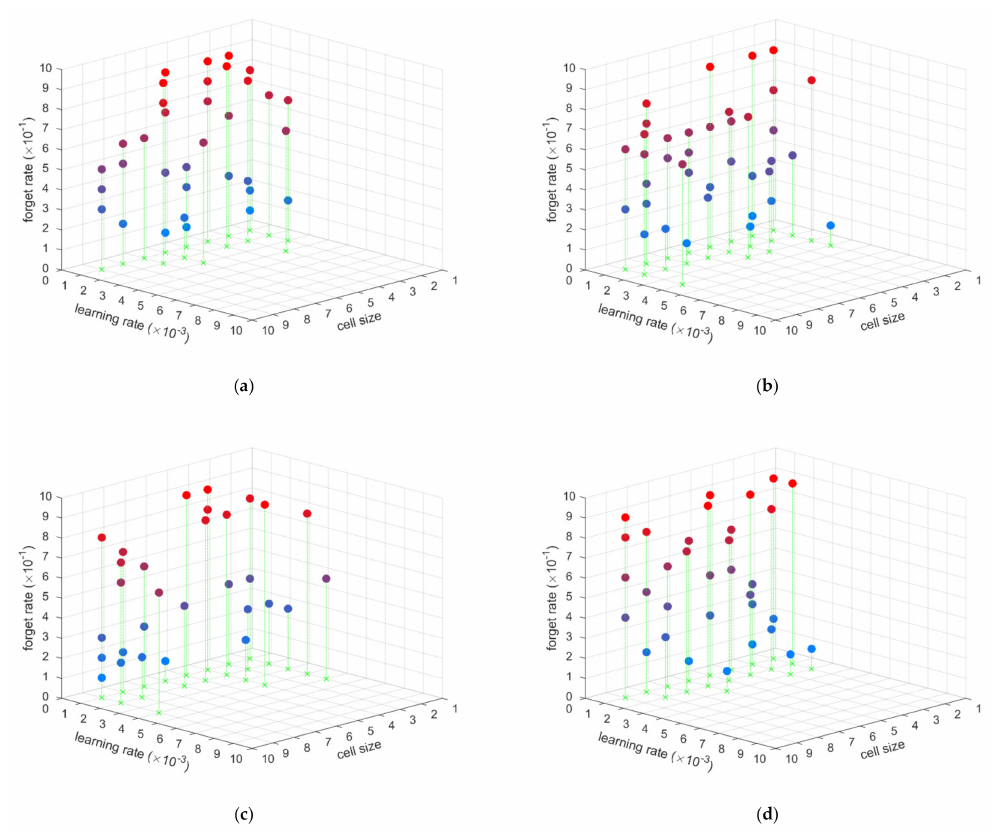
Figure 3. The hyperparameter evaluation for static position estimation: ( a ) batch size is 5, ( b ) batch size is 10, ( c ) batch size is 15, ( d ) batch size is